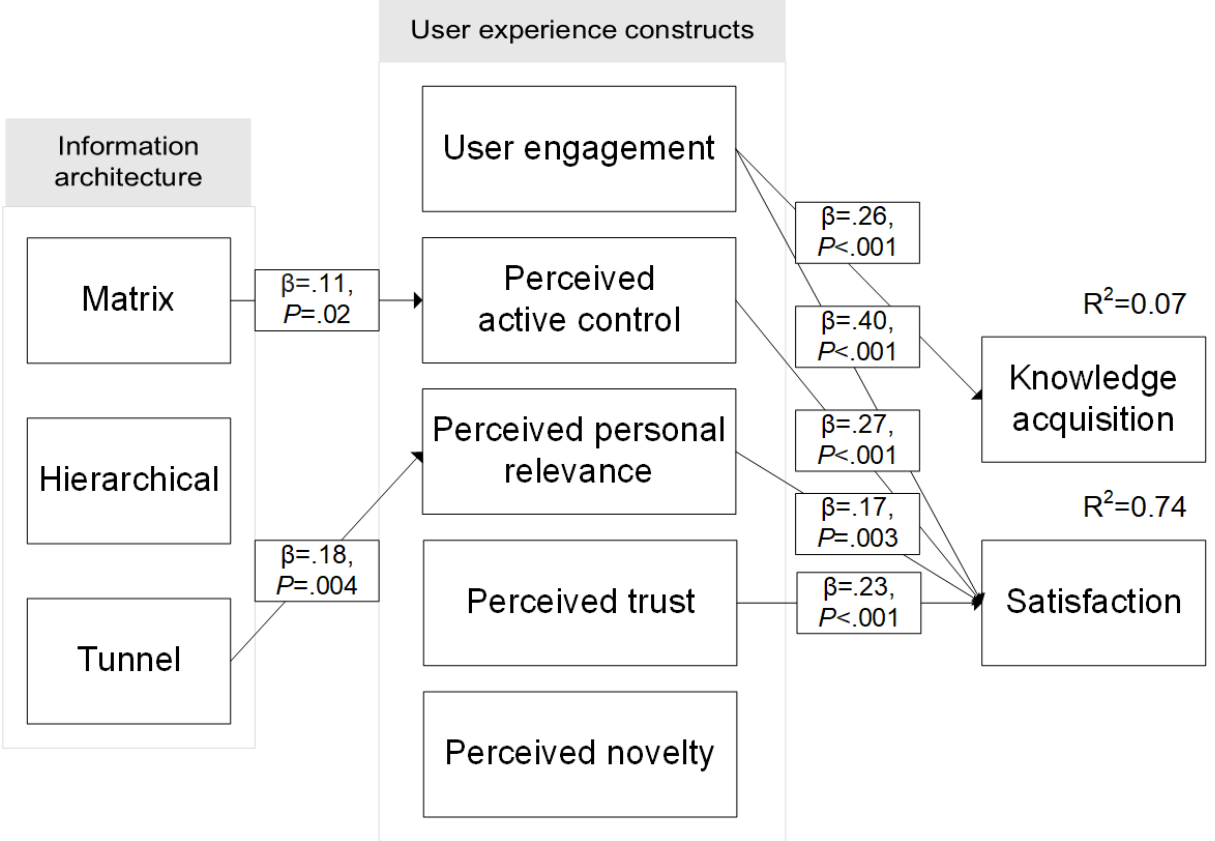
Figure 5. Structural equation model of the effects of information